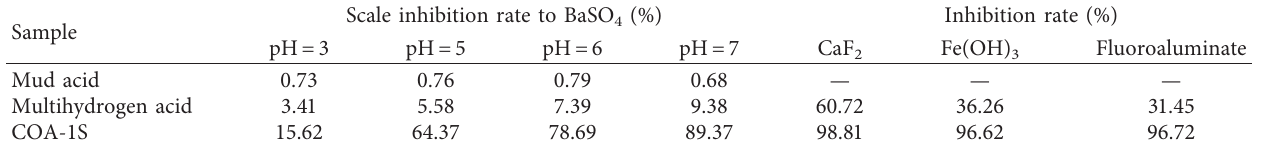
Table 1: The chelating performance of chelate acid COA-1S and other acids.